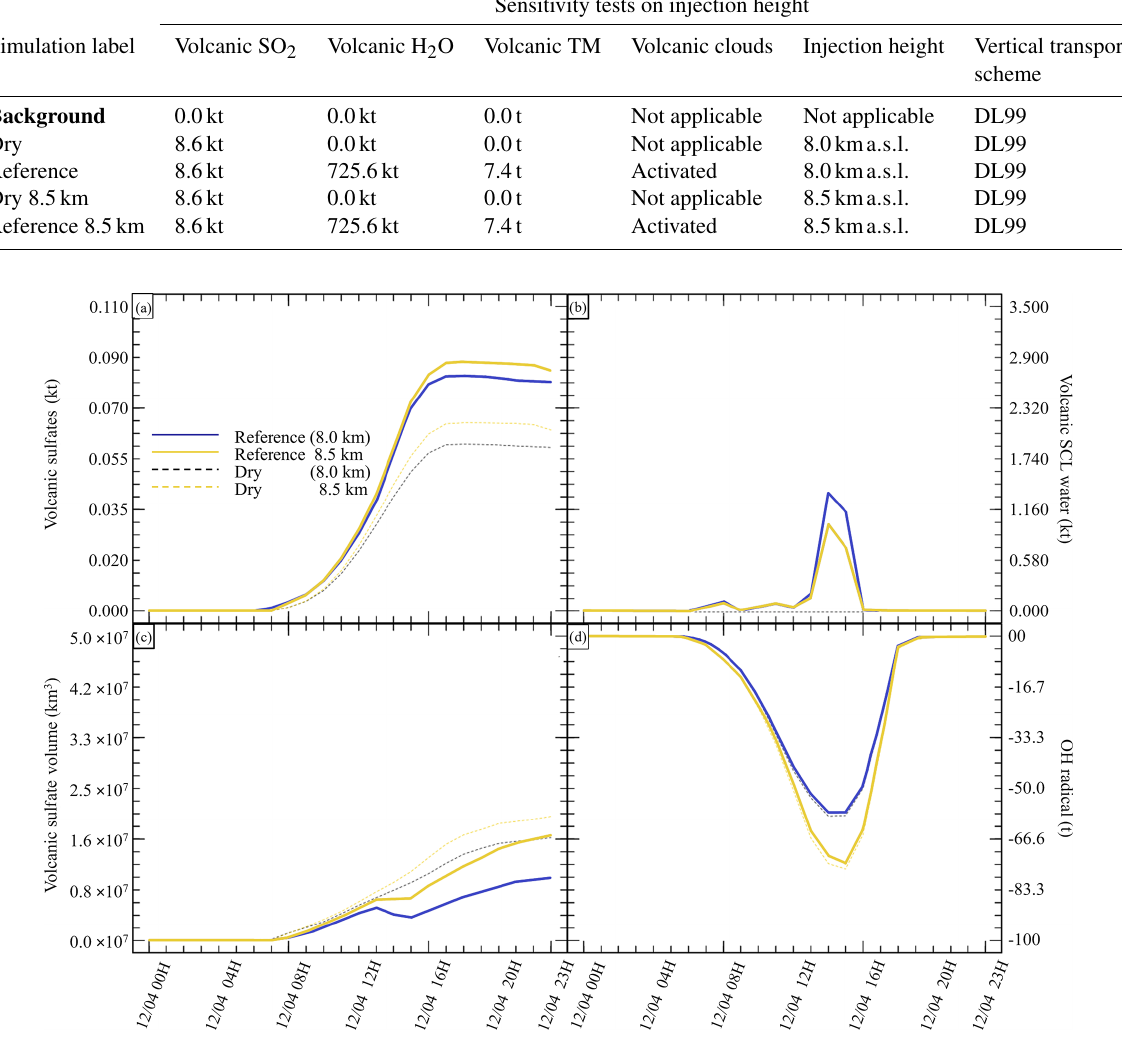
− , kt), (b) supercooled liquid water (kt), (c) the minimum volume Figure 5. Sensitivity tests on injection height for (a) sulfate aerosols (SO 2 4(p) (km 3 ) ⊂ 25% of SO 2 − mass and (d) OH radical (t). The Reference simulation is the closest to a realistic case. All time series represent 4(p) differences relative to the Background simulation (the simulation without volcanic